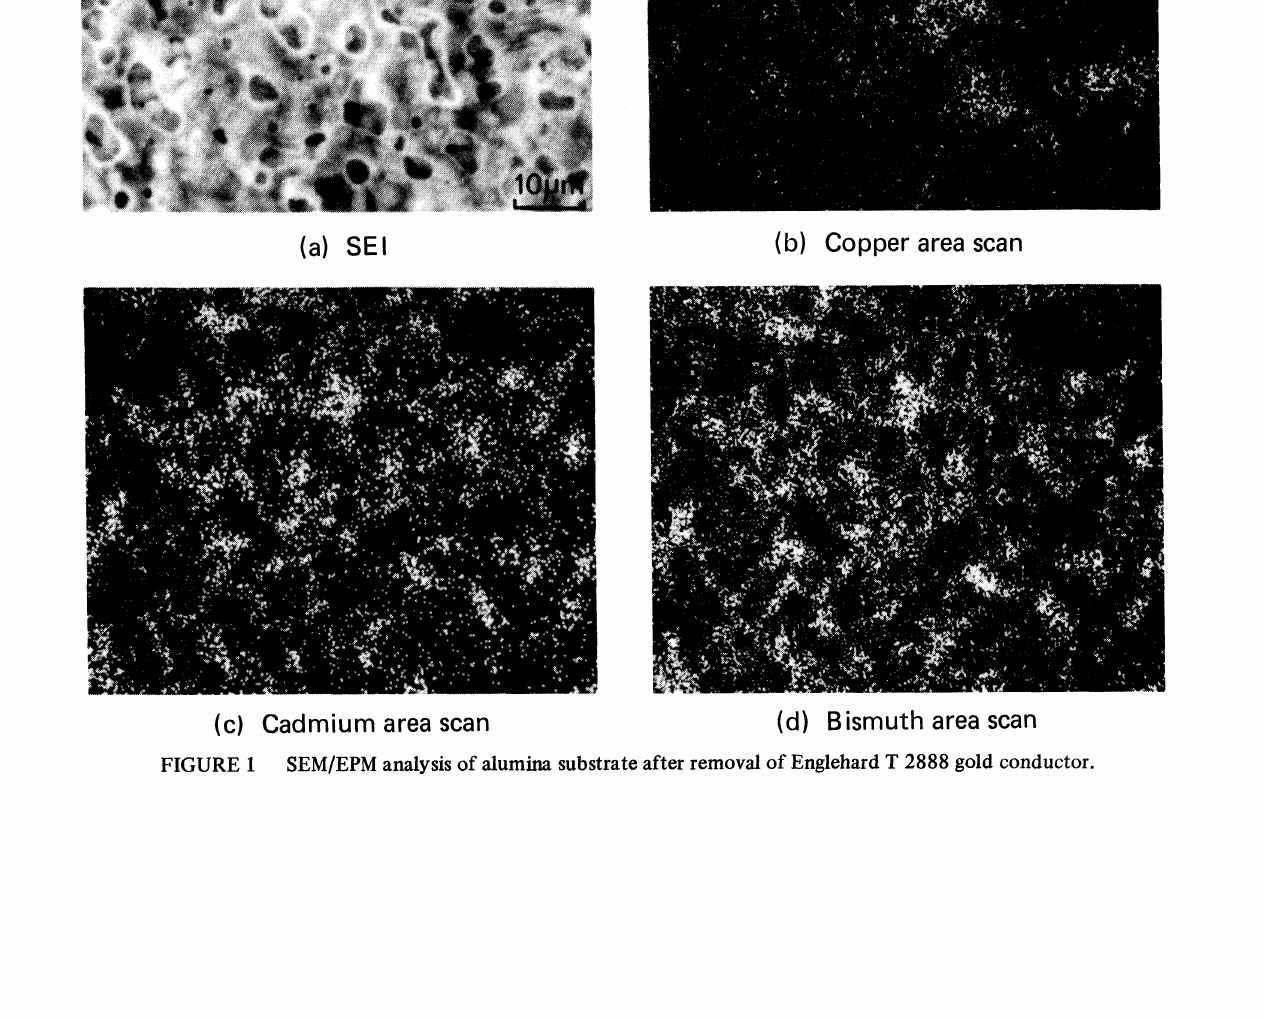
FIGURE 1 SEM/EPM analysis of alumina substrate after removal of Englehard T 2888 gold